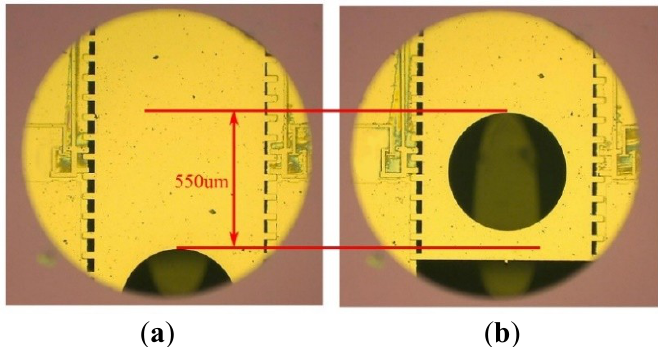
Figure 16. The movement results of the S&A device. ( a ) The safety position. ( b ) The armed position.